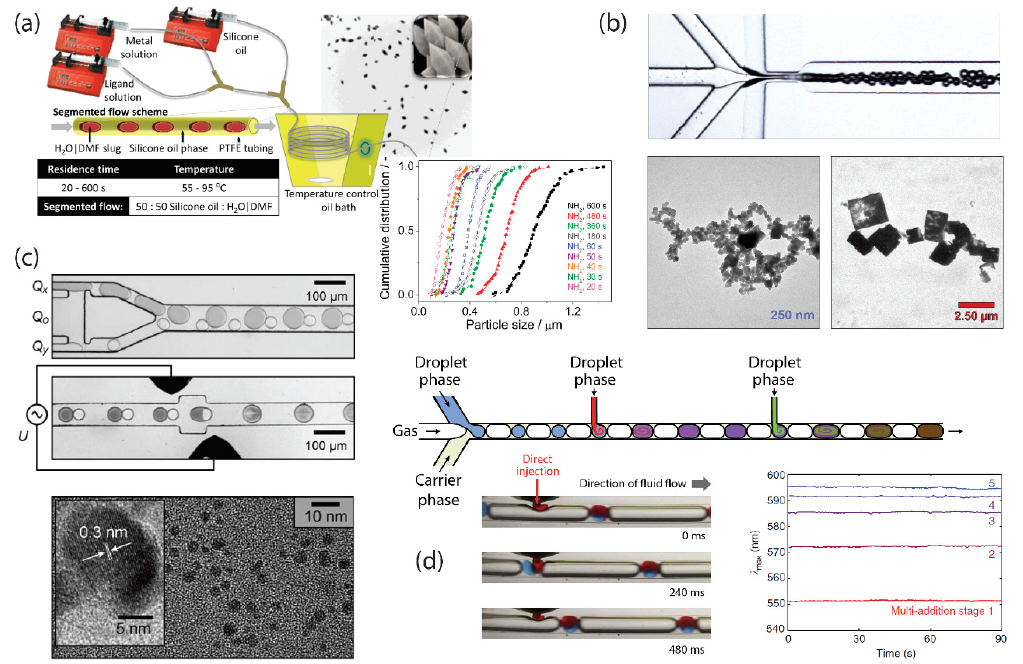
Figure 4. ( a ) Rational control of metal organic framework (MOF) crystal sizes by droplet microfluidics (adapted with permission from [55], copyright 2013 American Chemical Society). ( b ) Chip design and comparative TEM images of the particles of a spin crossover coordination polymer, obtained by microfluidic (left) and batch (right) syntheses (adapted from [35]). The microfluidic approach yield nanoparticles with 20 ‐ fold downsizing with respect to the batch reaction. ( c ) Droplet pair generator (Copyright Wiley ‐ VCH Verlag GmbH and Co. KGaA; reproduced with permission from [56]) and its application to synthetize monocrystalline iron oxide nanoparticles (copyright Wiley ‐ VCH Verlag GmbH and Co. KGaA; reproduced with permission from [32]). ( d ) Rational, sequential synthesis of cadmium selenide (CdSe) quantum dots by successive injections of reagents inside droplets (adapted from [57]).